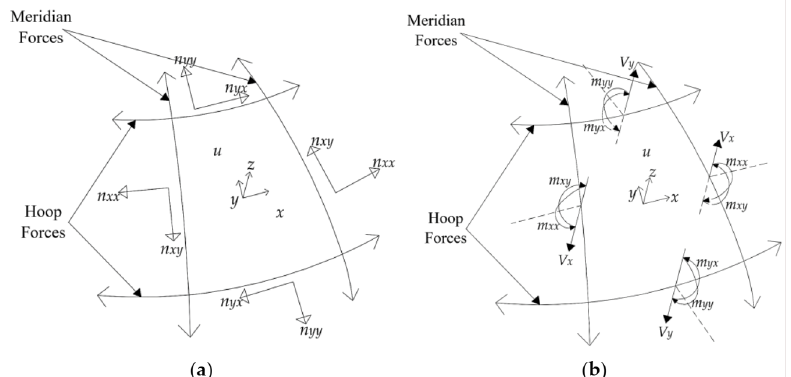
Figure 2. ( a ) Local membrane forces; ( b ) local moments and shear forces. Adapted from “Structural Shell Analysis, Understanding and Application”, written by Johan Blaauwendraad and Jeeroen H. Hoefakker